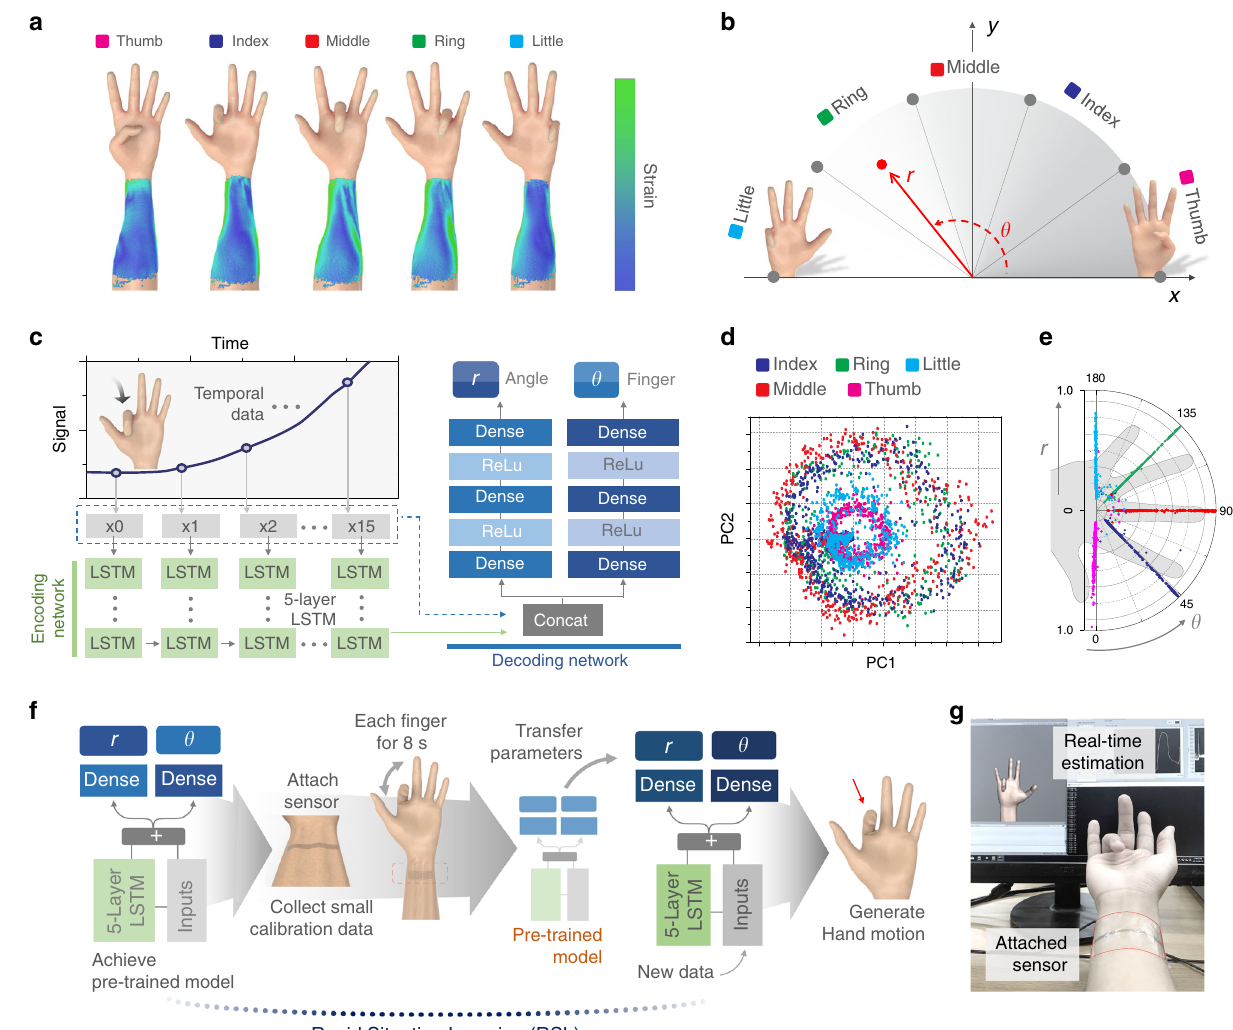
Fig. 4 Identifying human hand motions from detected skin deformation. a Depiction of skin deformations for different fi nger bending motions. b Metric space de fi ning single fi nger bending motions: physical alignment of fi ngers in a hand is expressed in the metric space with R representing the amount of a fi nger bent and θ identifying the position of a fi nger in a hand. c Neural network is composed of an encoding network and a decoding network. LSTM layers are used in encoding network to analyze temporal sensor patterns to generate latent vectors. Two independent dense layers map created latent vectors to our metric space expressing hand motions. Dropout is used as the regularization technique to prevent the network to be over fi tted to a single use case. d 2D PCA illustration of output vectors produced by encoding network. Each circular cluster demonstrates that encoding network can correctly identify cyclic fi nger motions from sequential sensor inputs. e Figure of how sensor inputs in training dataset are mapped to the metric space after passing our network. f The processes of rapid situation learning (RSL) that utilizes transfer learning. When the sensor is attached to a new position and a small amount of retraining data is collected, the new network utilizes knowledge learned during pretraining by transferring parameters from pretrained network, reducing the amount of dataset, and time for retraining. g Photo of actual hand motion